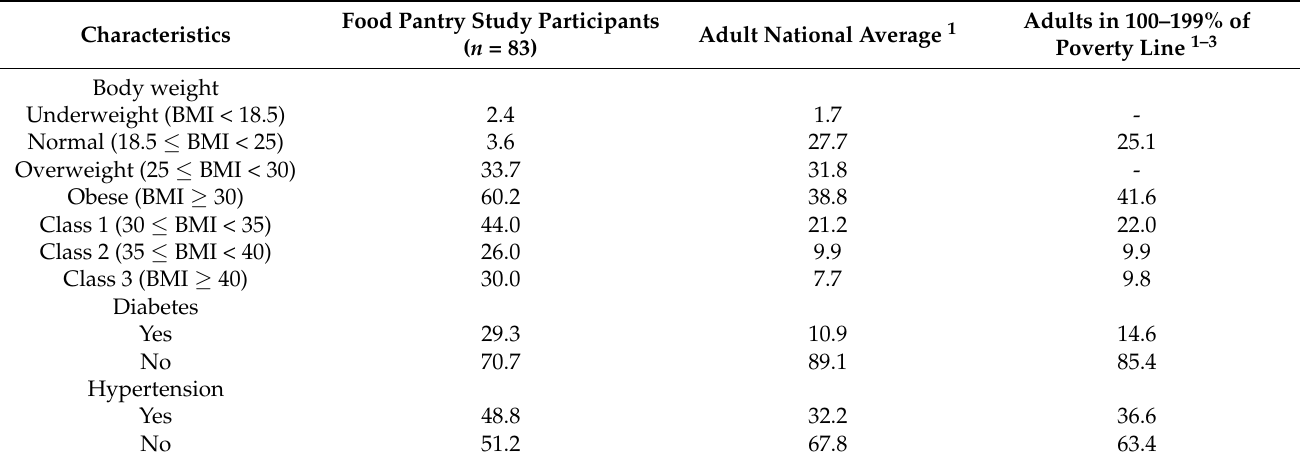
Table 2. Comparison of health status including obesity, diabetes, and hypertension between current food pantry study participants and average US adults or other food pantry participants